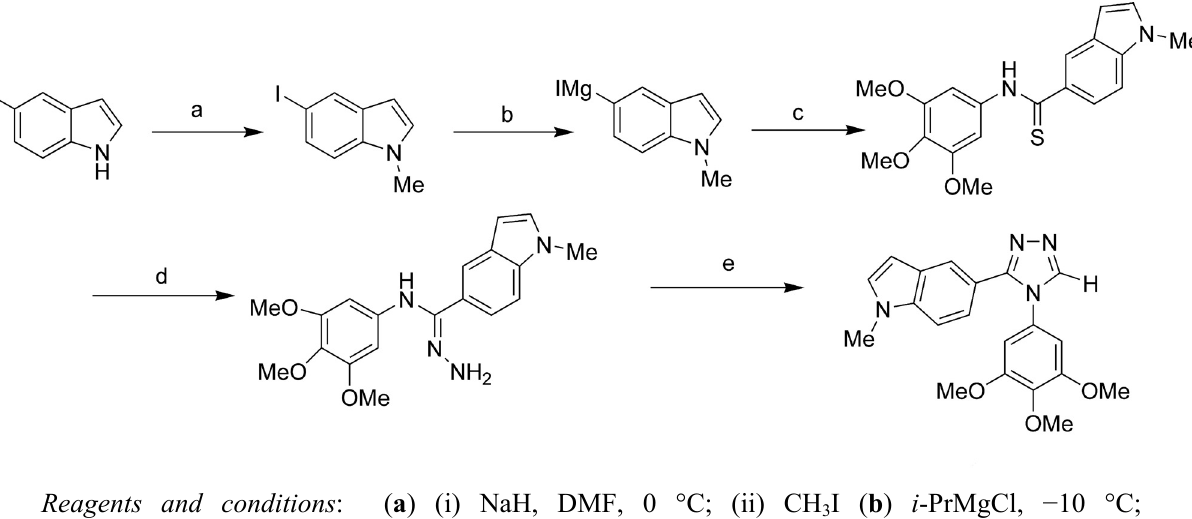
Figure 23. Synthesis of 1,2,4-triazoles with a N -methyl-5-indolyl moiety: tubulin